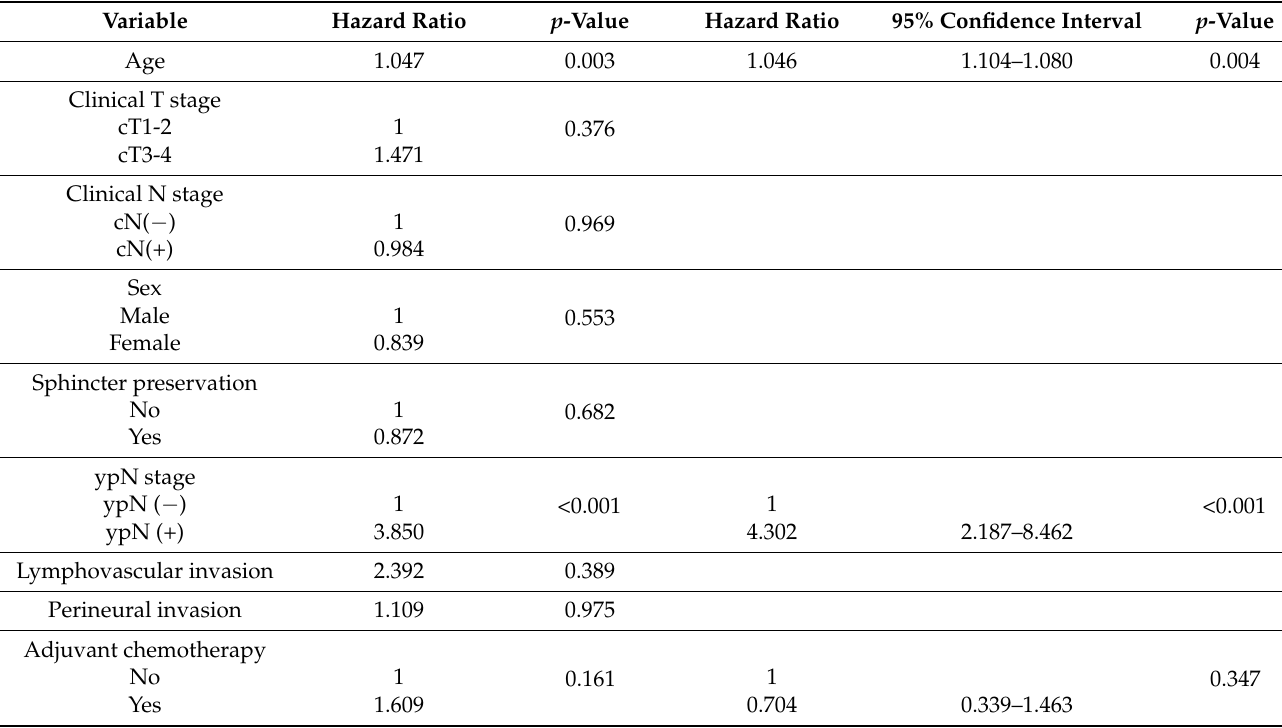
Table 5. Factors associated with overall survival in ypT0-1 rectal cancer treated with radical resection after preopera- tive